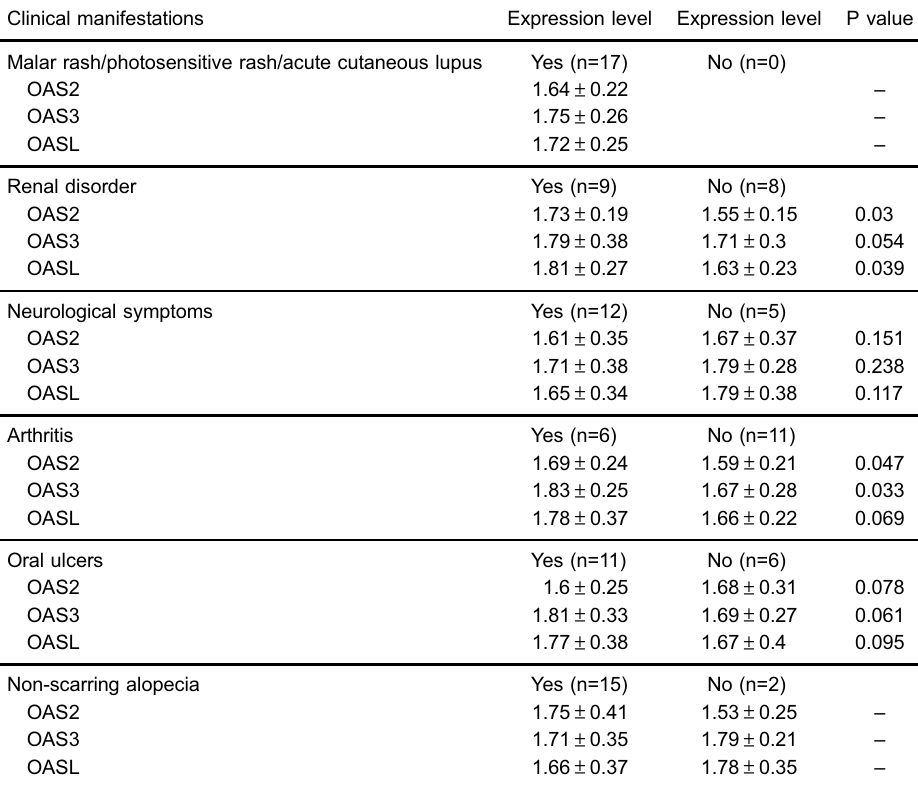
Table 4. Association of OAS2, OAS3, and OASL expression in peripheral blood mononuclear cells with systemic lupus erythematosus